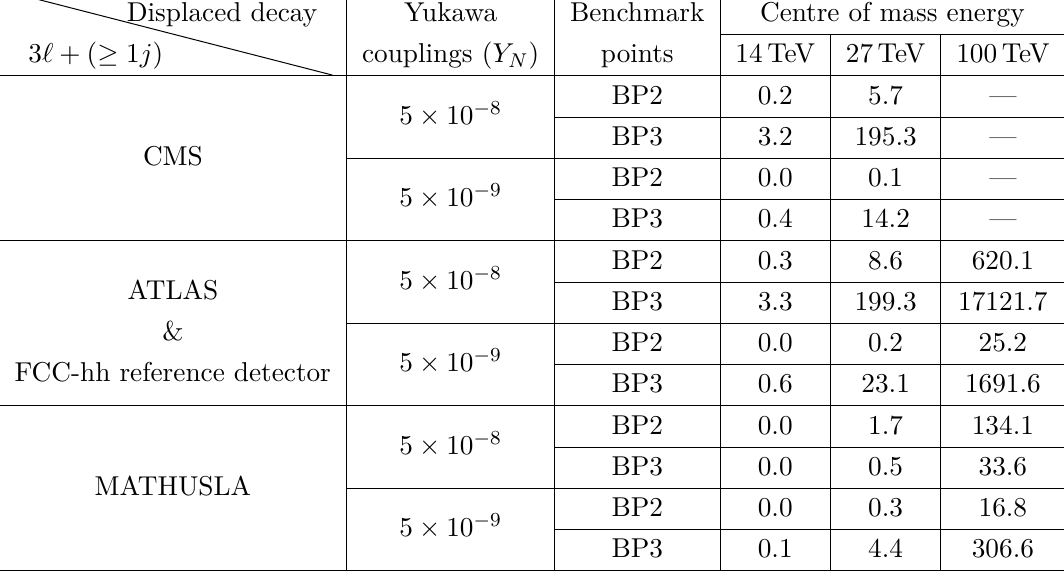
Table 13. Number of events in 3 ‘ +( ≥ 1 j ) final state for the benchmark points, corresponds to the Yukawa couplings Y = 5 × 10 − 8 and 5 × 10 − 9 , with the center of mass energies of 14 TeV, 27 TeV N